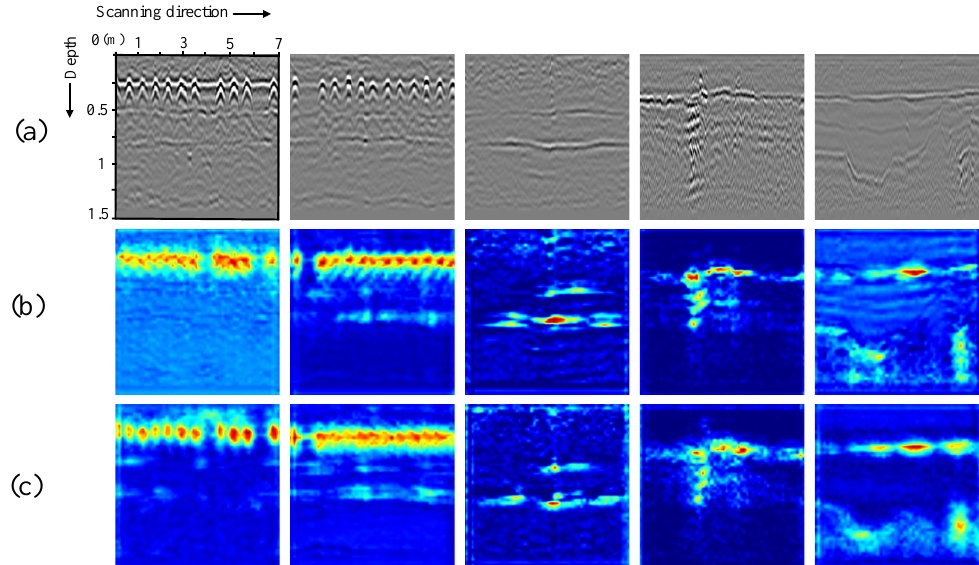
Figure 15. Grad-CAM visualization results: ( a ) Original B-scan image; ( b ) is Grad-CAM visualization for dense layer; ( c ) is Grad-CAM visualization for Radar-channel attention submodule. Red regions correspond to high score for class. Figure best viewed in color. For simplicity, we only add a coordinate axis to the first graph in the upper left corner, and the rest are the same.